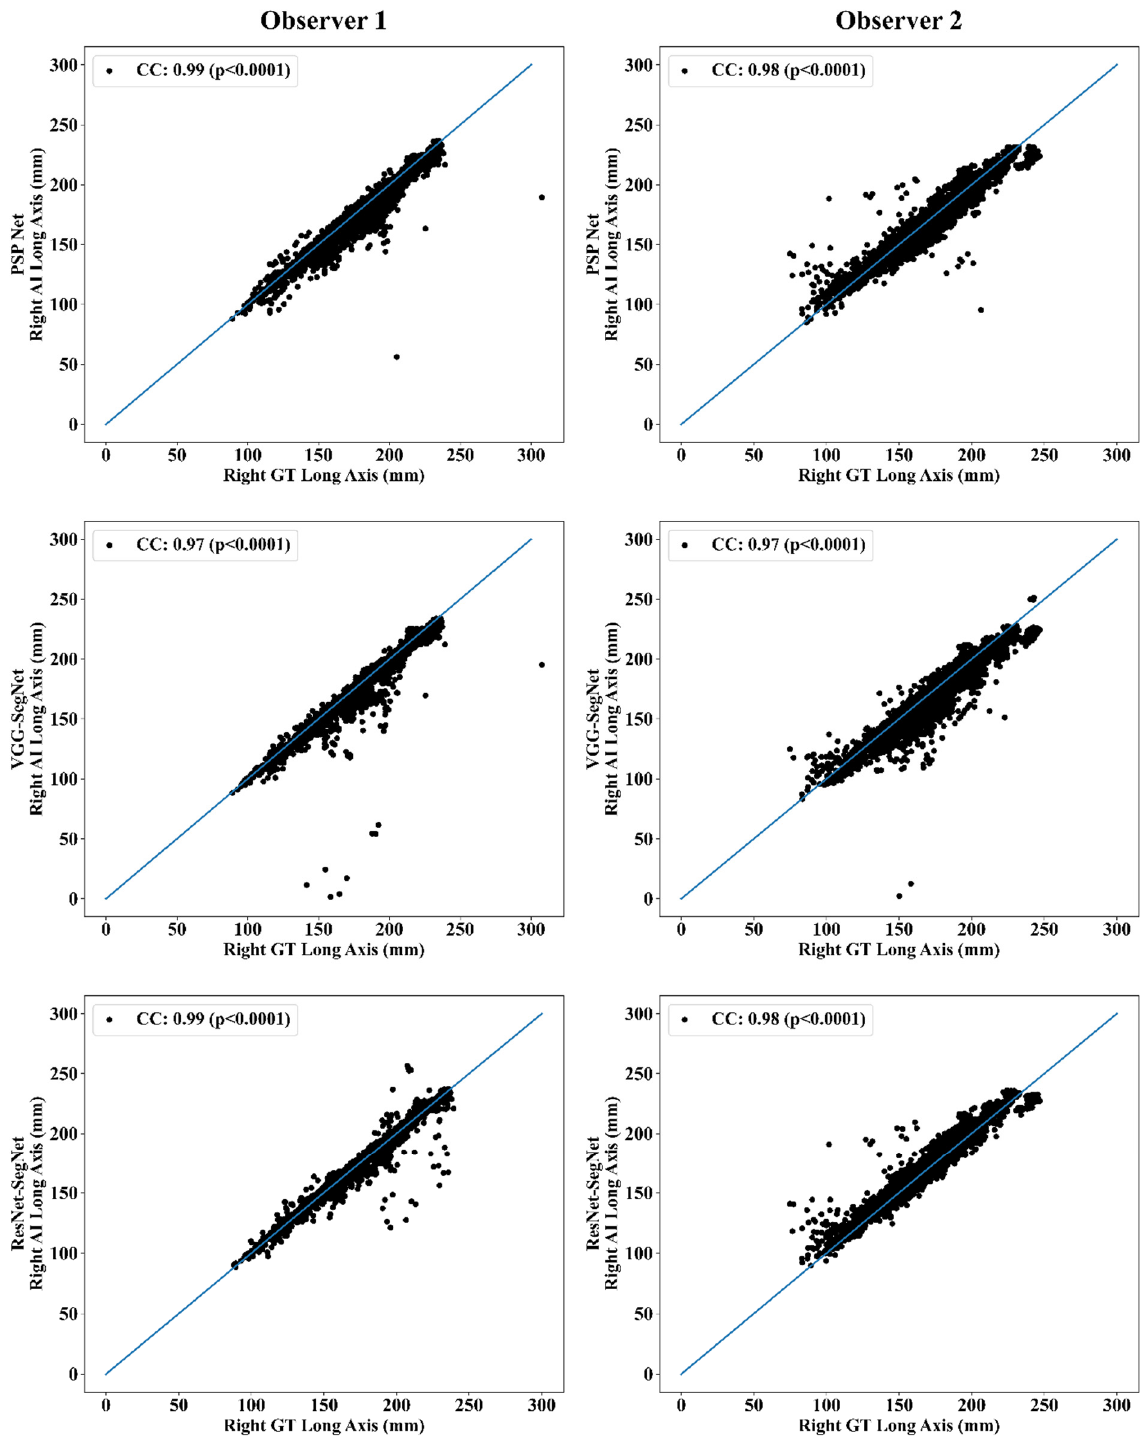
Figure 24. CC of right LLA using three AI models: Observer 1 vs. Observer 2. Bland-Altman Plots for Lung Long Axis Error The (i) mean and (ii) standard deviation of the lung long axis corresponding to Observer 1 and Observer 2 for the three AI models is shown in Figure 25 for the left lung and Figure 26 for the right